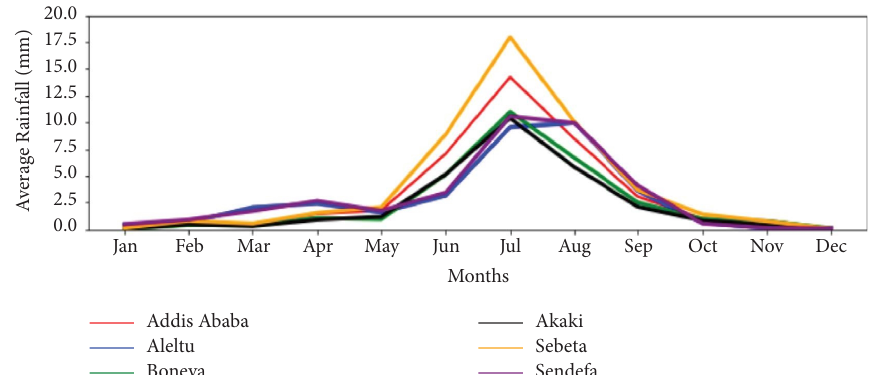
Figure 2: Monthly average rainfall intensity at each